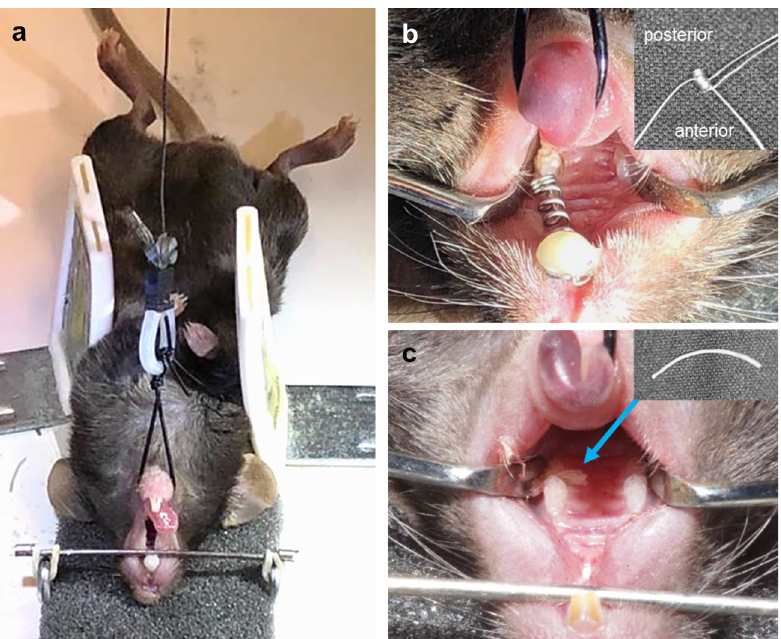
Figure 5. ( a ) Custom-made fixation apparatus for orthodontic interventions in mice. Details see manuscript text. ( b ) Halved 0.25 N NiTi coil spring ( Inset: auxiliary wires inserted into spring ends) between the first upper left molar and the upper incisors for experimental anterior tooth movement of the first upper left molar. ( c ) Elastic band (Ø 0.3 mm, see arrow, Inset ) between the first and second upper left molar for experimental anterior tooth movement of the first upper left